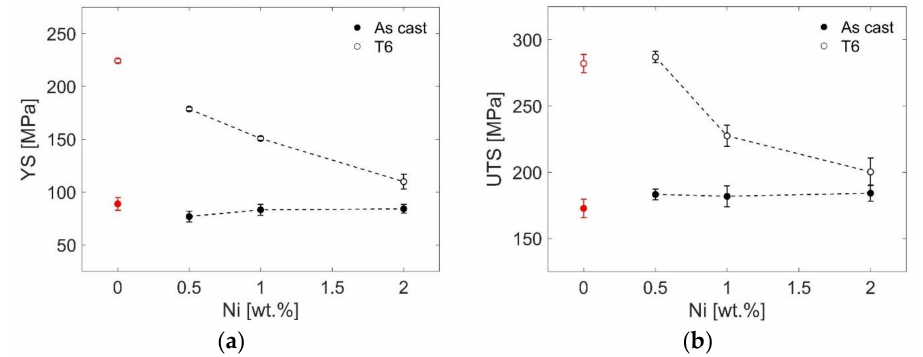
Figure 1. Tensile properties of specimens in as-cast and T6 conditions: ( a ) YS; ( b ) UTS. Red